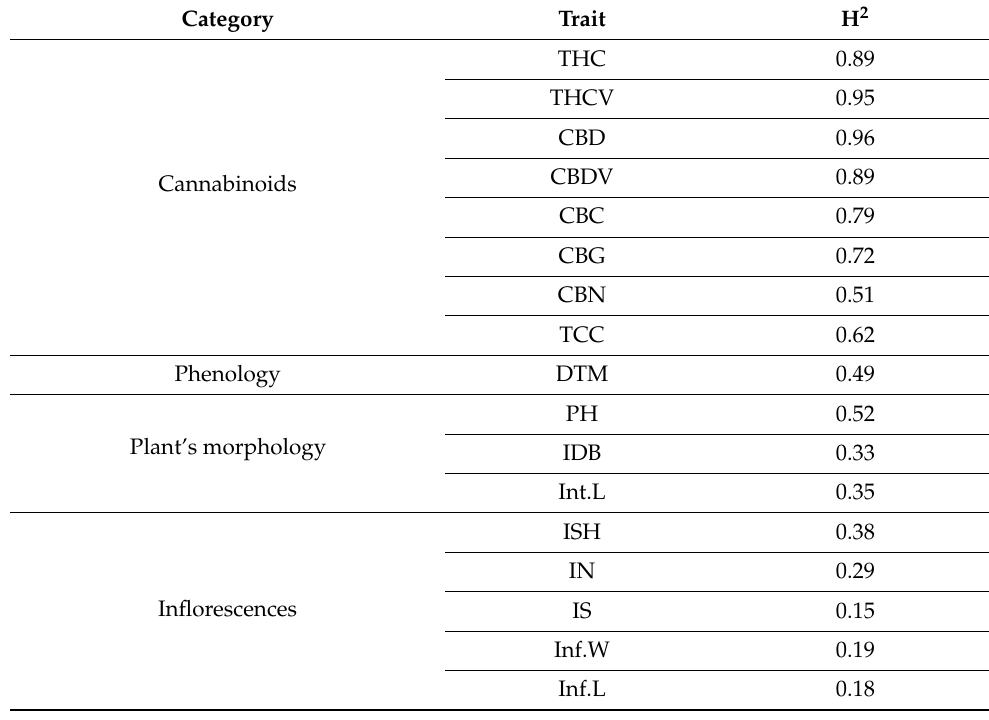
Table 1. Broad-sense heritability of cannabinoid biosynthesis, plant phenology, physiological traits and inflorescence morphology. Abbreviations: total cannabinoid concentration (TCC), days to matu- ration (DTM), plant height (PH), inflorescence dry biomass (IDB), average internode length (Int.L), inflorescence shape (ISH), inflorescence number (IN), average inflorescence size (IS), inflorescence width (Inf.W), inflorescence length